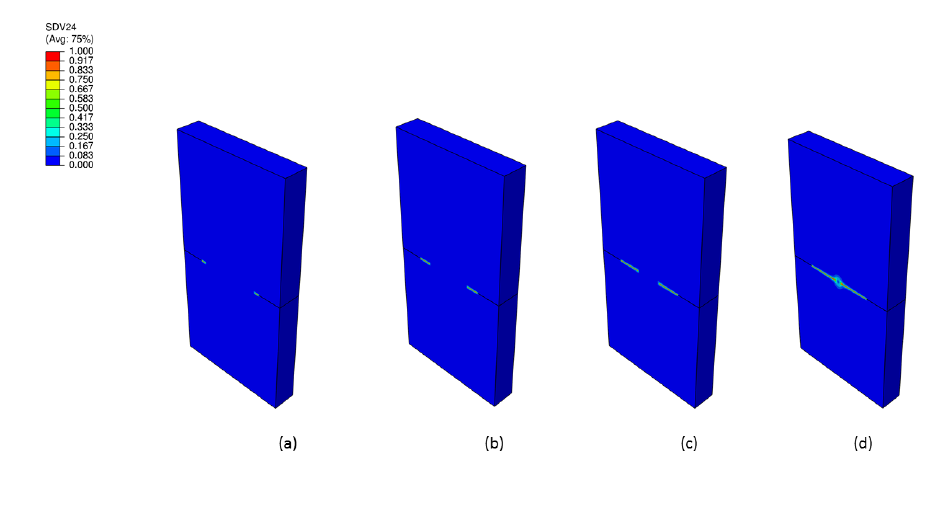
Figure 8. Crack path at different time steps: ( a ) initial damage after 100 time steps; ( b ) initial damage after 100 time steps; ( c ) initial damage after 100 time steps; and ( d ) final crack